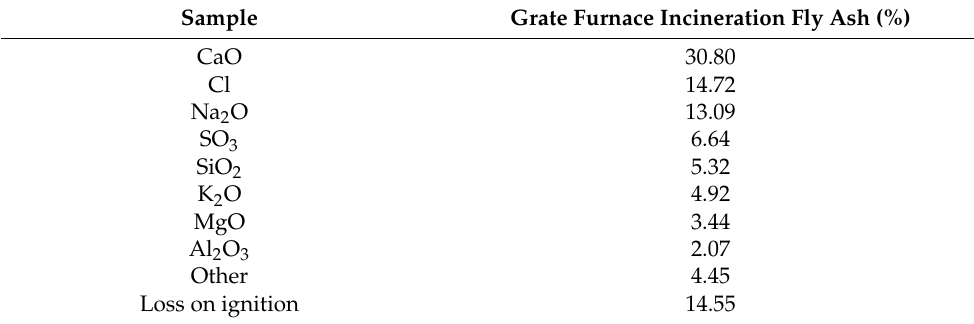
Table 1. The chemical composition of fly ash.